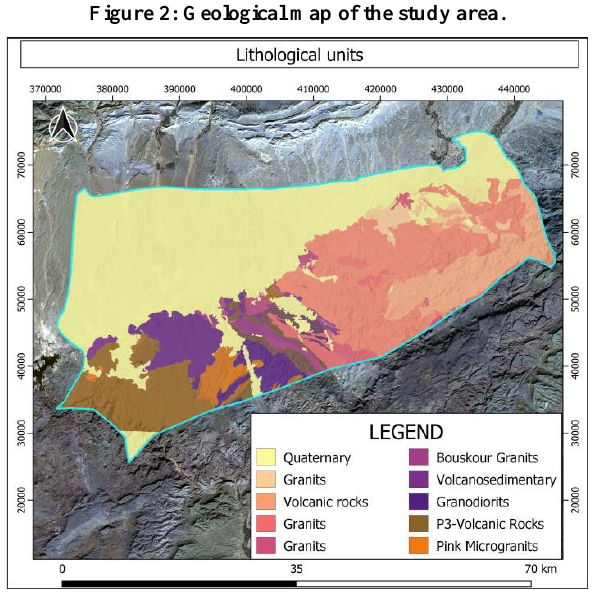
Figure 4: Elevation map of the study area. The elevation value at each pixel was used as the labeled data for the